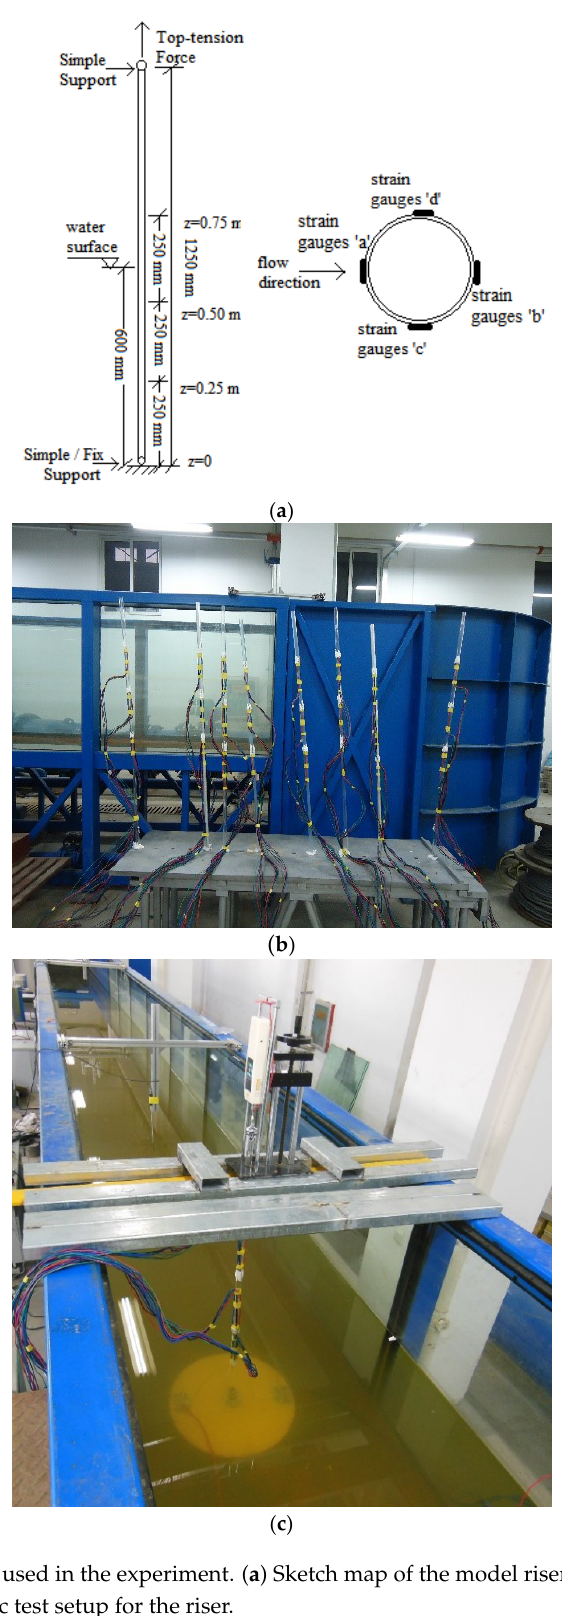
Figure 2. Riser model used in the experiment. ( a ) Sketch map of the model riser; ( b ) risers used in the experiment; ( c ) holistic test setup for the riser.